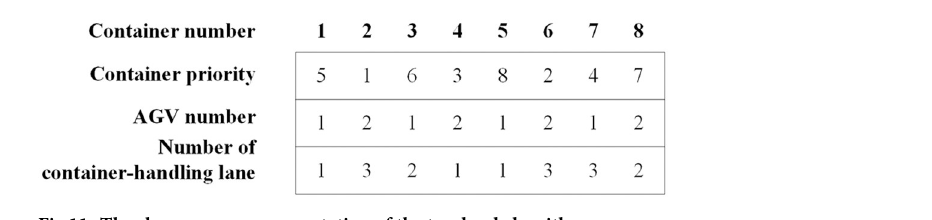
Fig 11. The chromosome representation of the top-level algorithm.